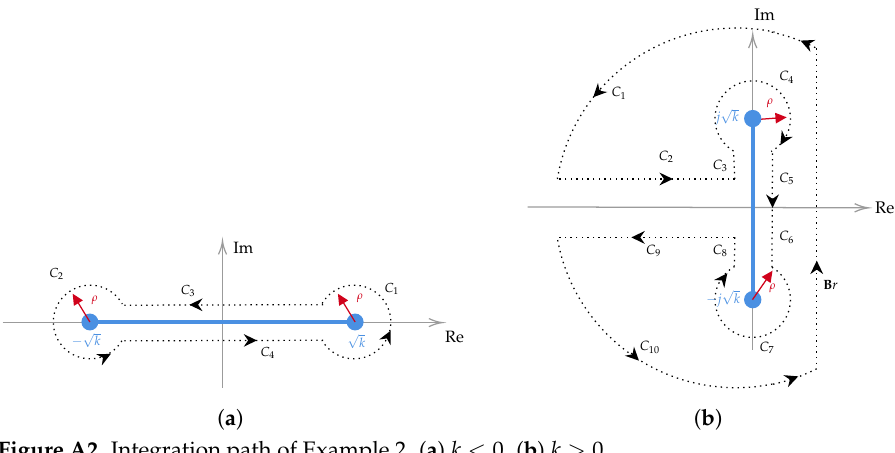
Figure A2. Integration path of Example 2. ( a ) k < 0. ( b ) k >